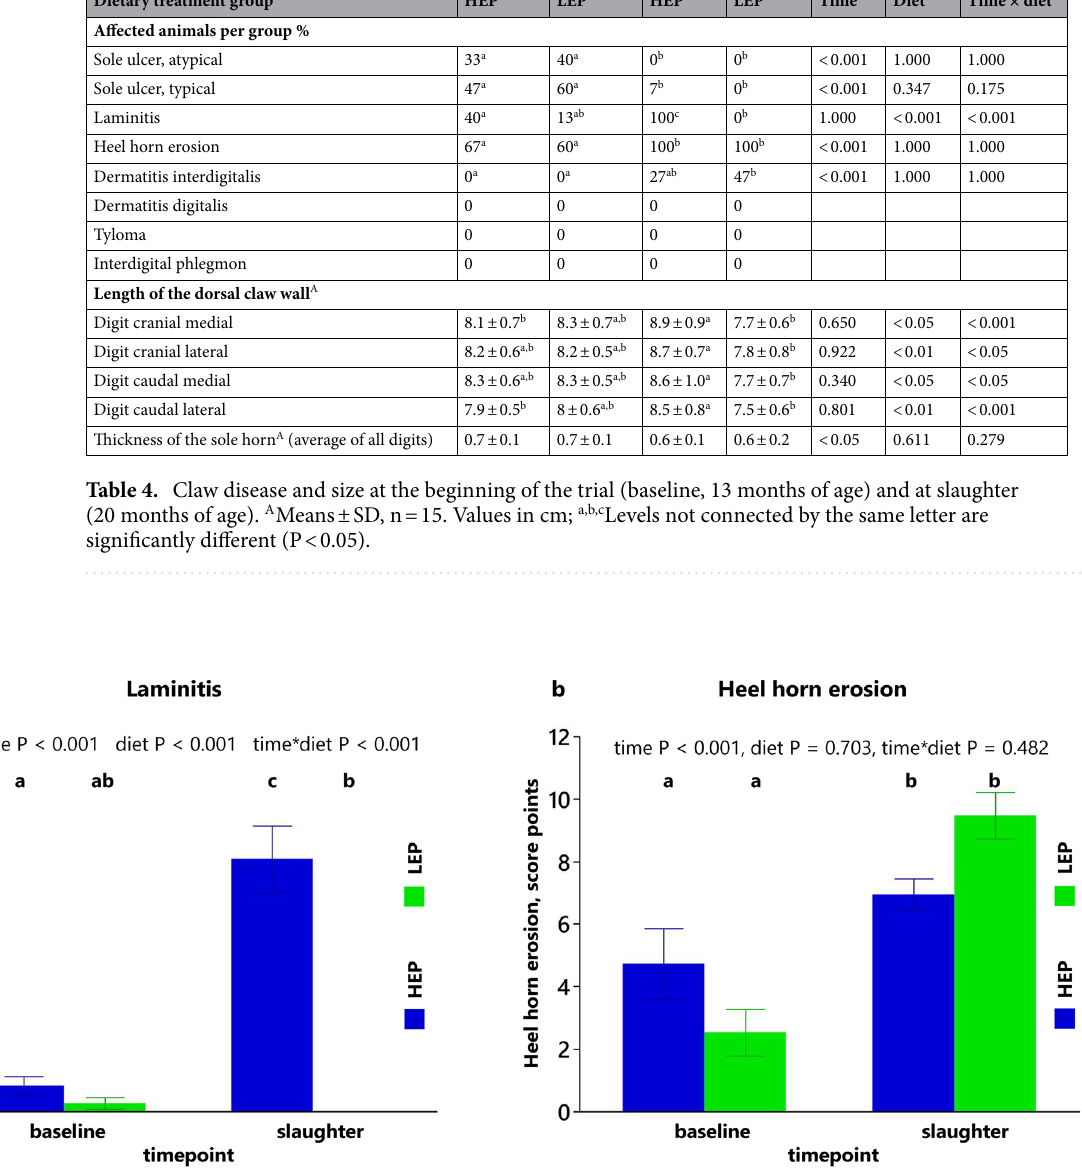
Figure 2. Claw disease. ( a ) Score points of laminitis and ( b ) score points of heel horn erosion at baseline and slaughter. Data shown as means ± SEM, n = 15, different letters indicate significant difference (P < 0.05). HEP = group fed high energy and protein diet, LEP = group fed low energy and protein